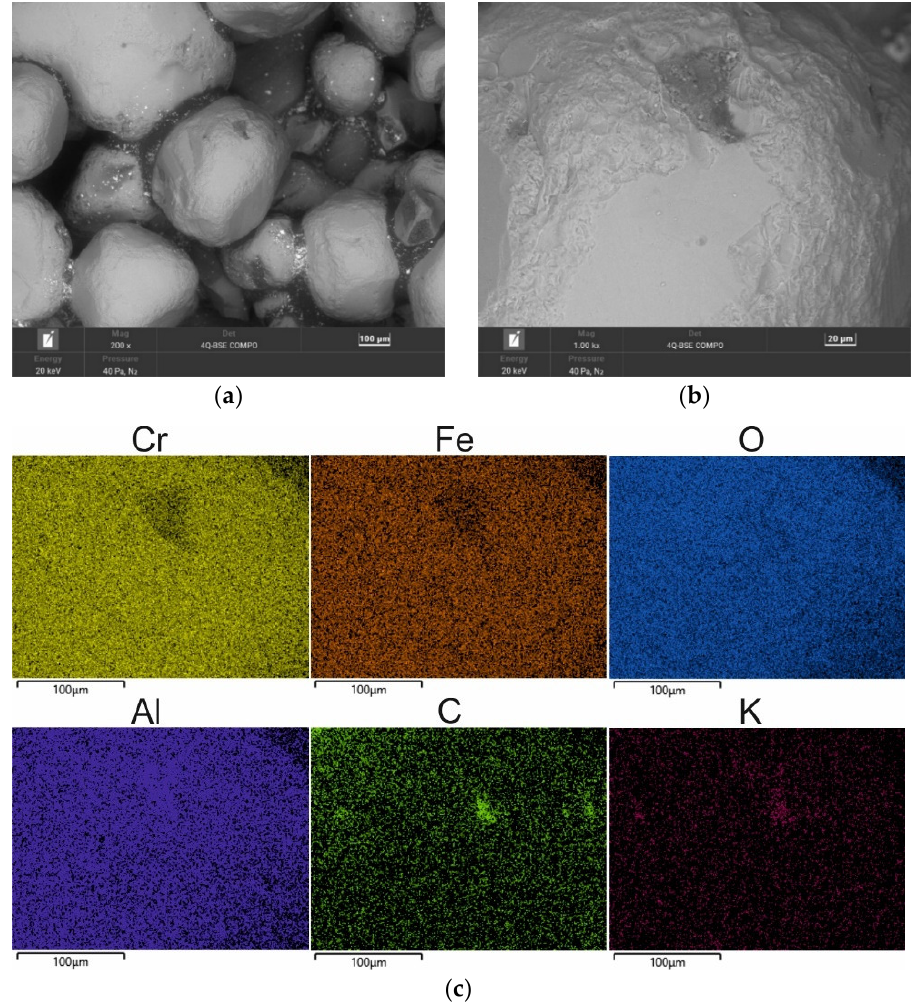
Figure 9. SEM image of 15 min MR15M-reclaimed sand: ( a ) mag. 200×; ( b ) mag. 1,000×; ( c ) EDS map of element distribution in the analysed area of MR15M-reclaimed sand.